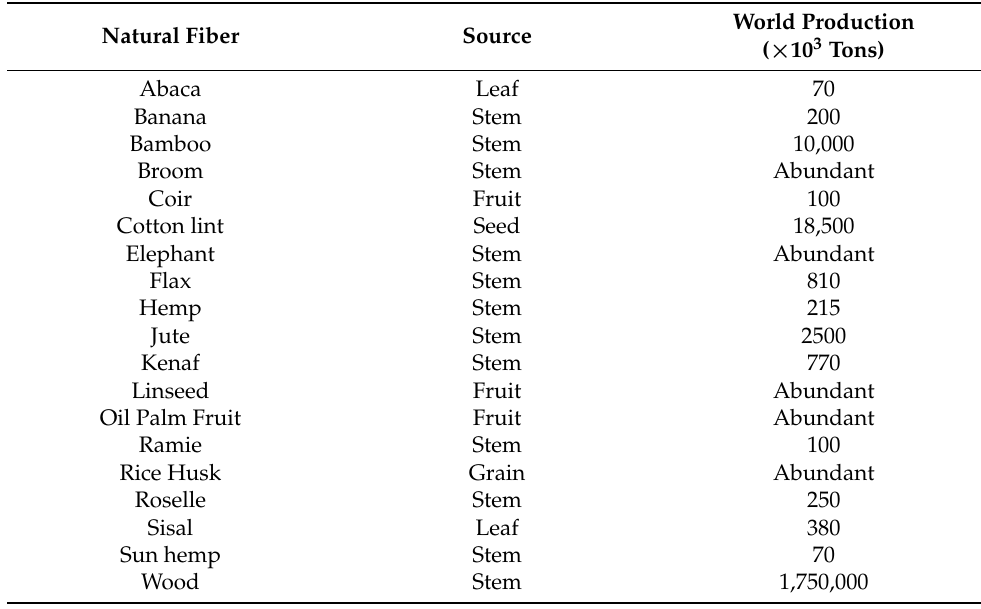
Table 1. Annual natural fibers production. Extracted with permission from